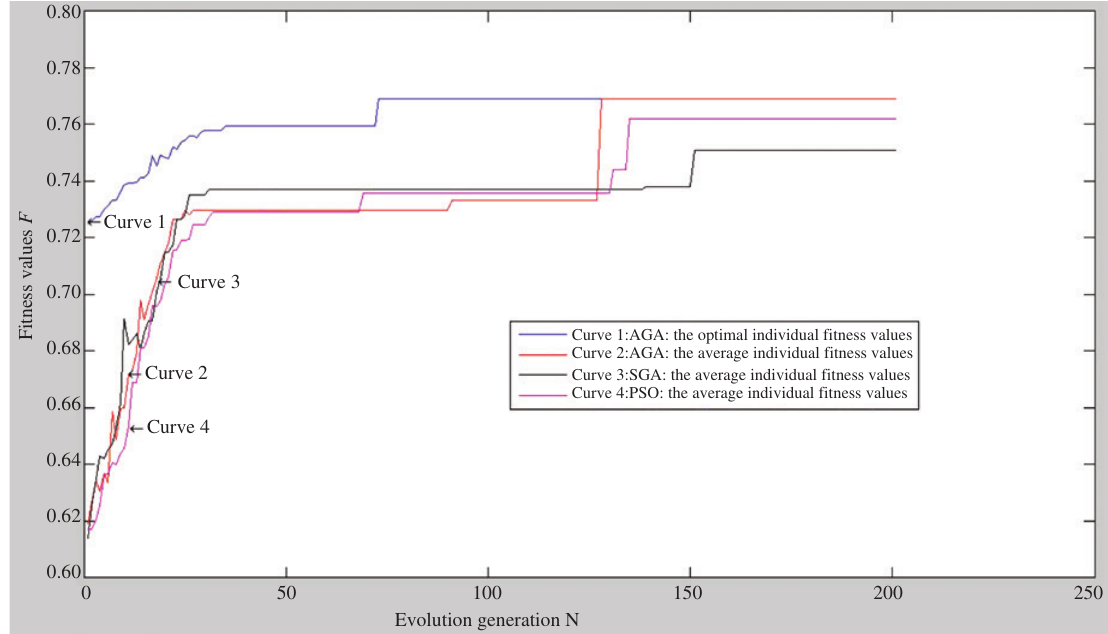
Figure 10: The Running Results of AGA and SGA.